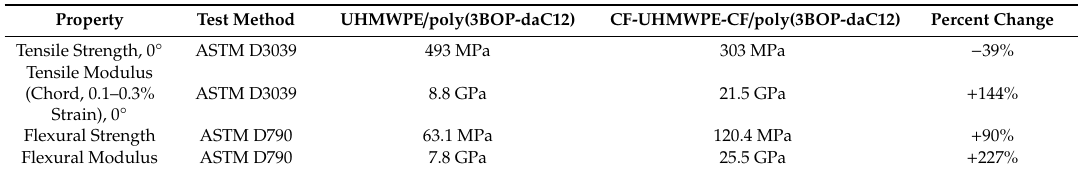
Table 4. Comparison of room temperature tensile and flexural properties for UHMWPE /